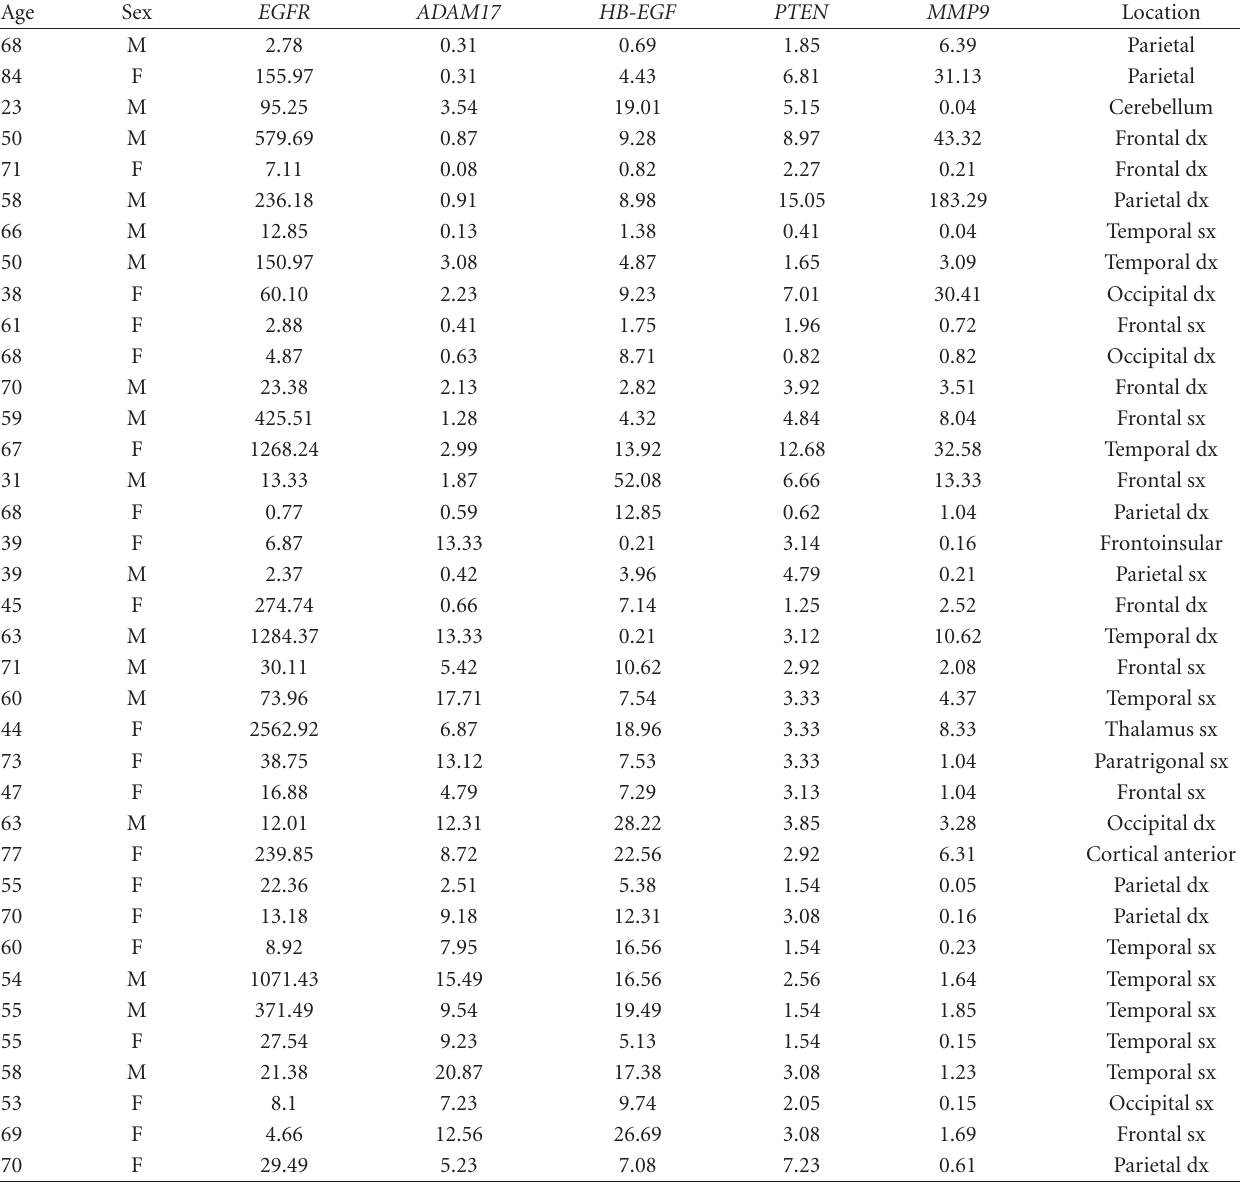
Table 1: Age, gender, mRNA expression values (in femptograms), and anatomical location of glioblasytoma multiforme